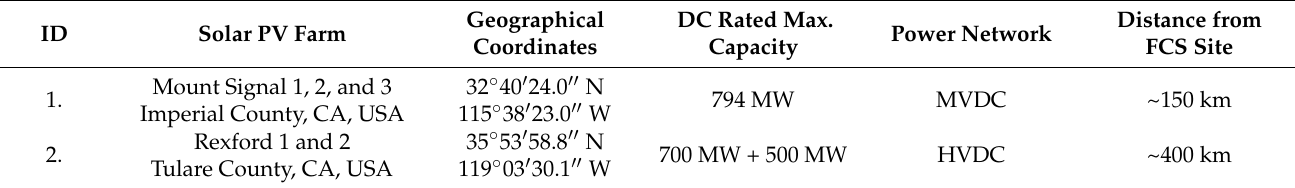
Table 4. Specifications of PV farms incorporated in the model [66,67].